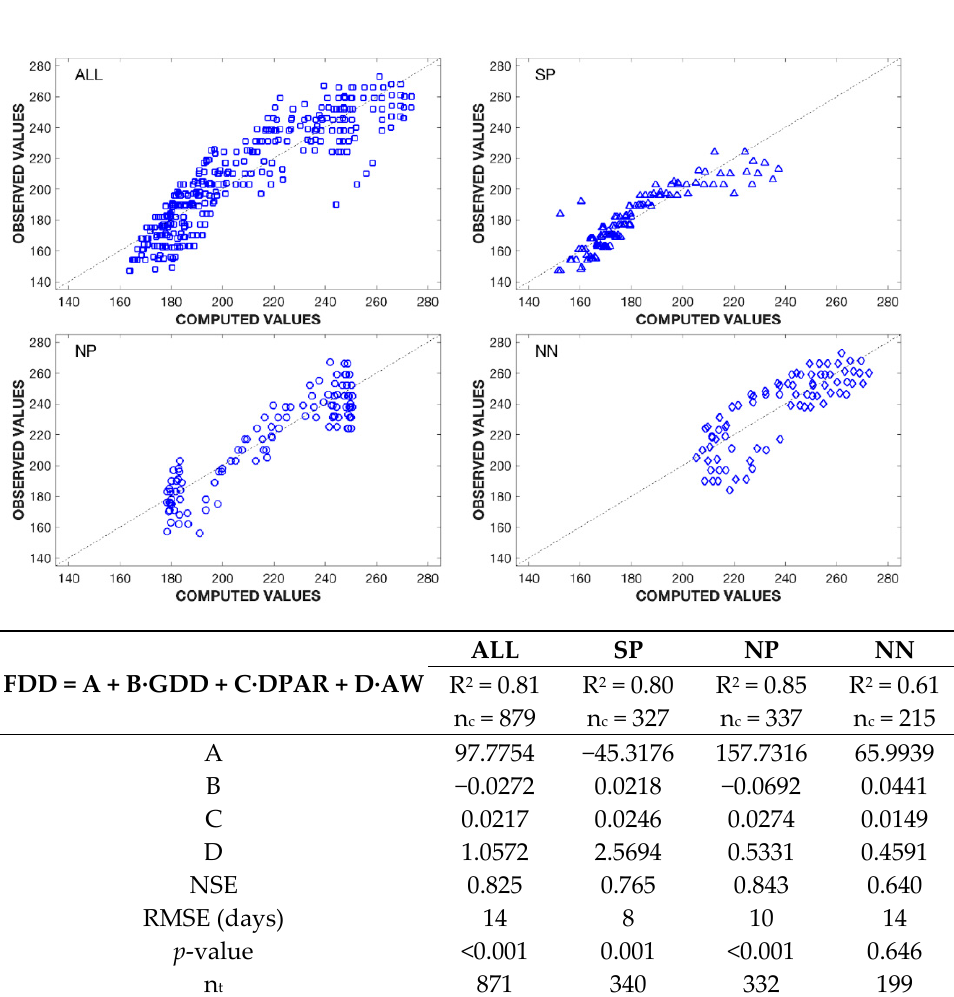
Figure 5. Performance of the multilinear regression (MLR) models for estimating fruit development days (FDD) from cumulative growing degree days (GDD), total daily photosynthetically active radiation (DPAR), and anthesis week (AW, expressed as number of the week). The evaluated MLR models with coefficients A to D were obtained individually for each location studied (SP, NP, and NN), but also an MLR model common to all locations (ALL) was fitted. The n c and n t indicate the number of data used for the model calibration and testing, respectively.